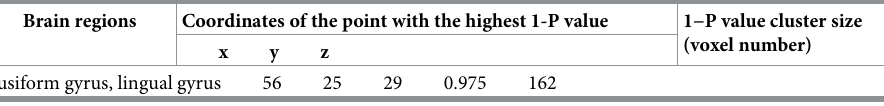
Table 2. Brain regions showing group differences in gray matter